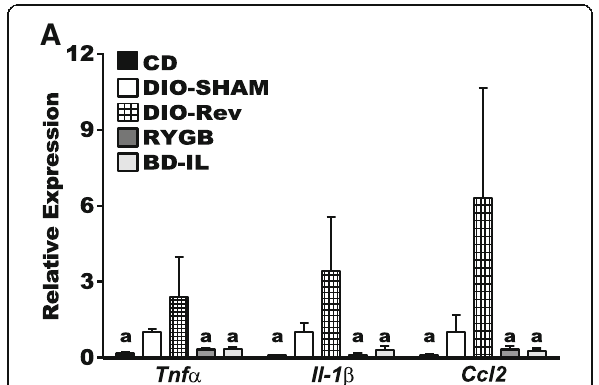
Fig. 4 RYGB and BD-IL procedures normalize hypothalamic inflammatory gene expression. a Hypothalamic expression by qRT-PCR of pro-inflammatory genes relative to DIO-SHAM control. a = significant difference from DIO-SHAM. p < 0.05 ( n = 5 – 8 per group). Data are represented as mean ±